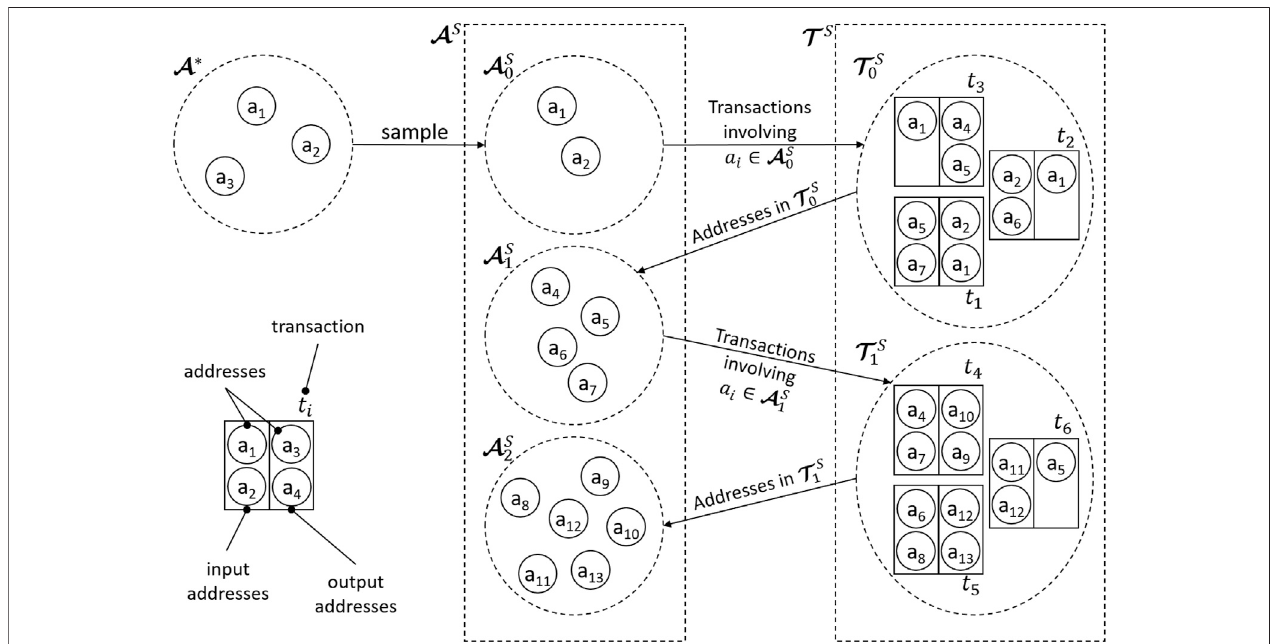
FIGURE 1 | The transaction sampling